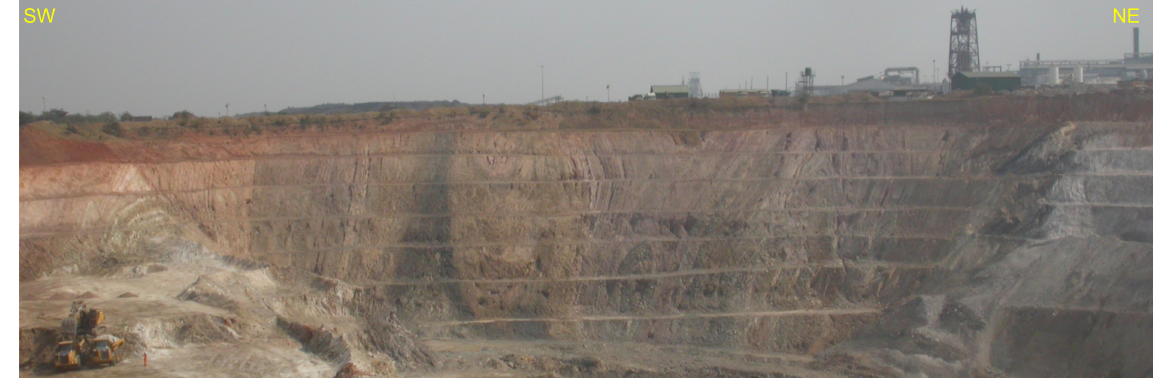
Figure 9. Cross-section view towards the north-west side of the Nkana South open pit, taken 14 August 2012. See Supplement for location where photo was taken. The COM is the black layer, showing isoclinal folding and pinched-out fold hinges. Compare with Fig. 8b for geology in